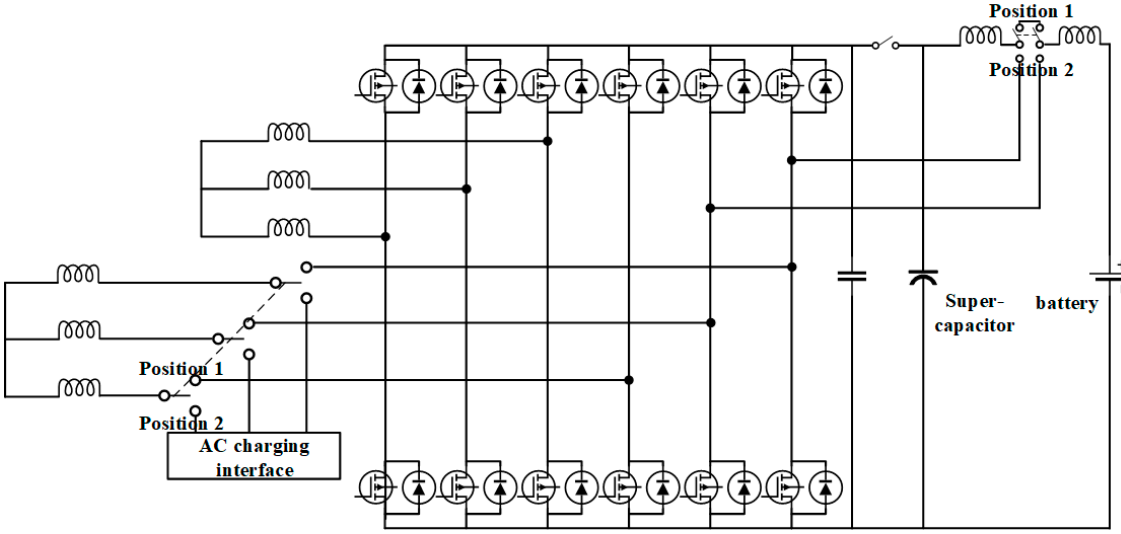
Figure 1. Power circuit of the integrated topology.